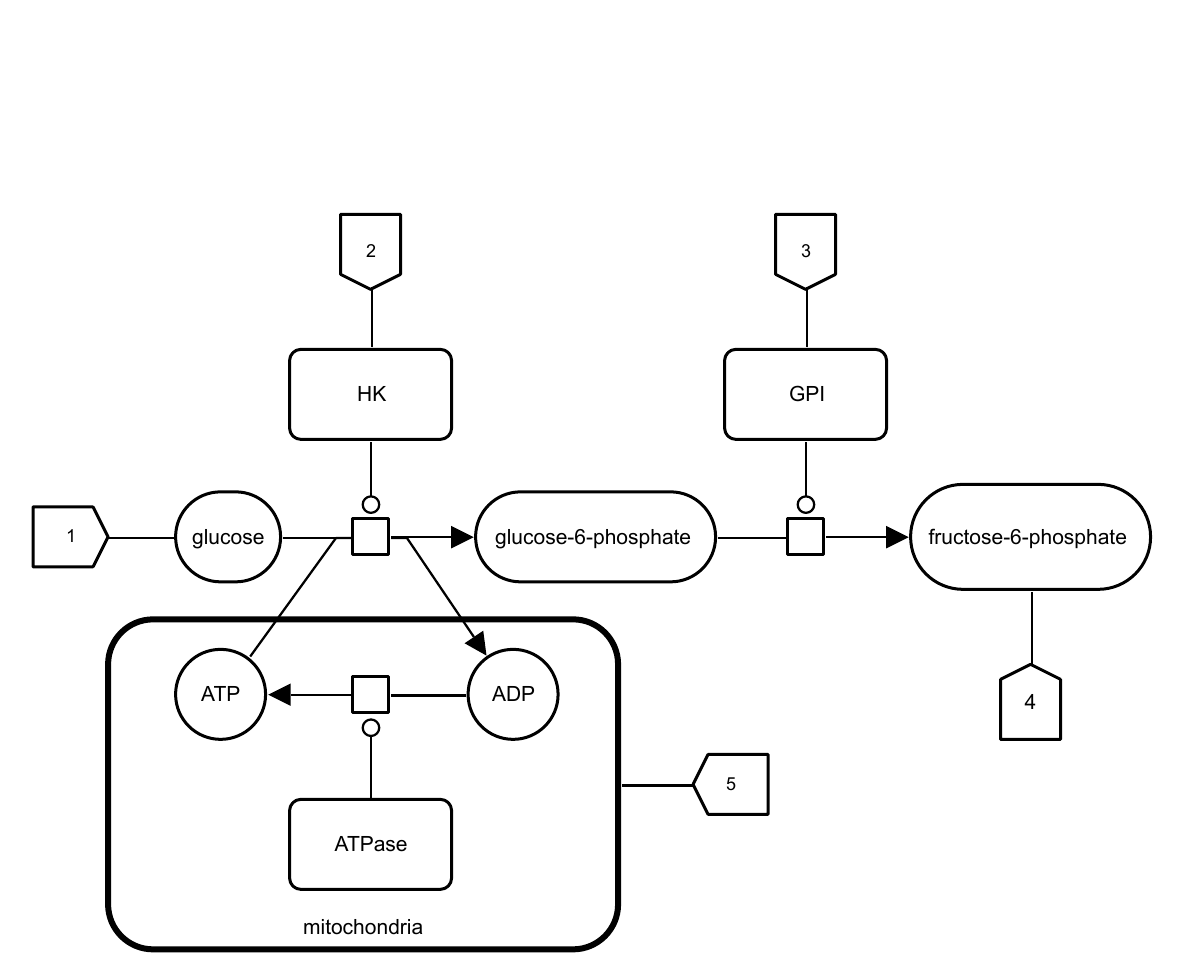
Figure 2.61: Example of a map with tags , showing that it is enclosed in a submap of another map (here, the one of Figure 2.60 on the previous